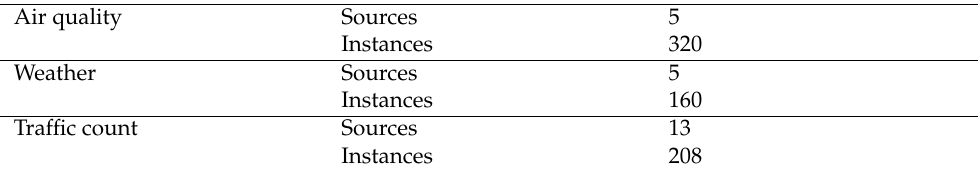
Table 1. Data statistics of the studied area.